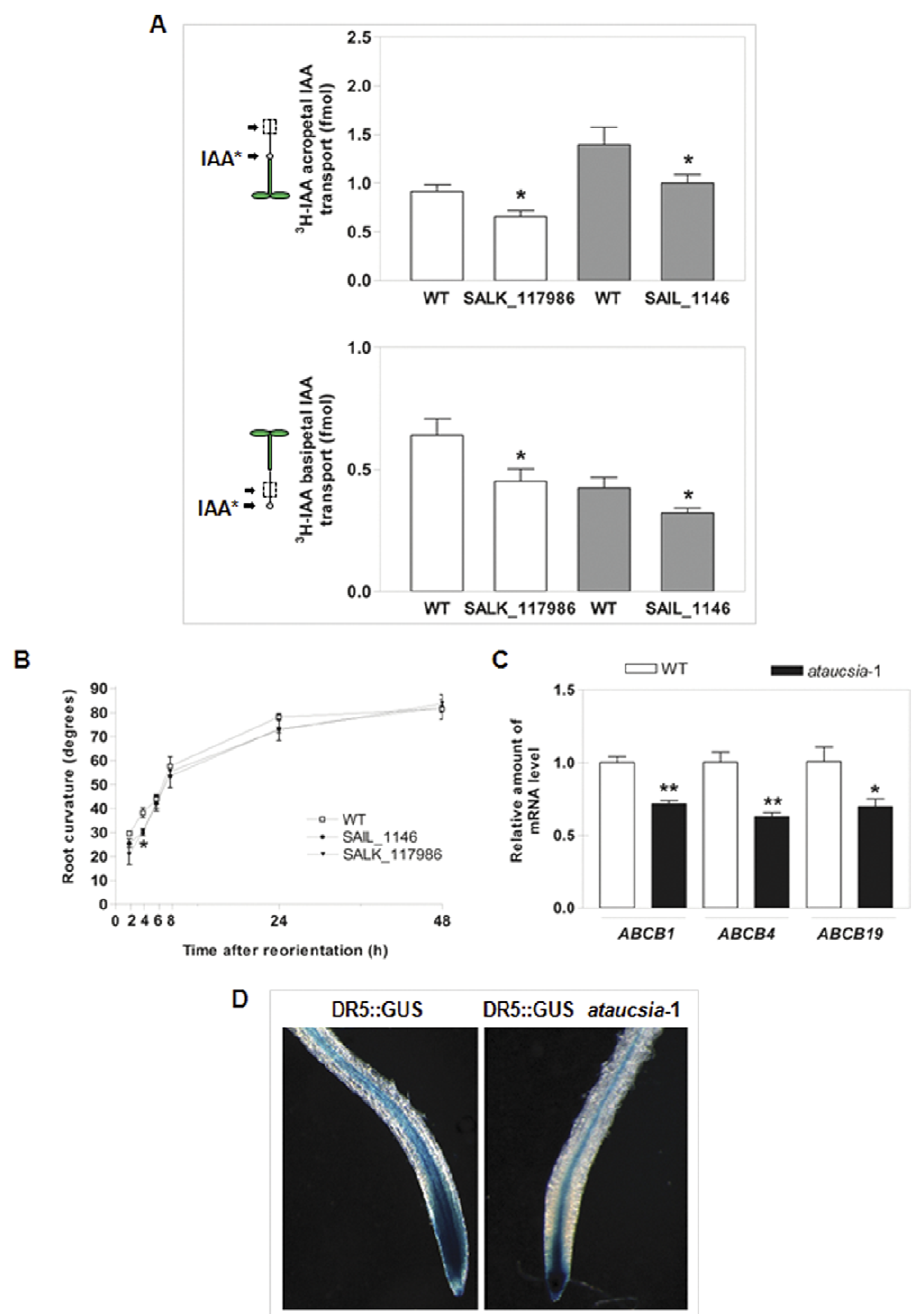
Figure 3. Polar auxin transport in ataucsia -1 mutants. (A) Auxin transport measurement in 5 days old wild-type and ataucsia -1 mutant seedlings. (Upper) For acropetal IAA transport assay, an agar drop containing 3 H-IAA was applied just below the root–shoot junction. (Lower) For basipetal IAA transport assay, 3 H-IAA agar drop was positioned to the apical 0.5 mm of the root tip. The schematic drawings on the left represent the mode of 3 H-IAA application. The boxes indicate the segment in which radioactivity was measured. Results are reported as means 6 SE (n=3) 15–20 seedlings per replicate. (B) Time course analysis of gravitropic curvature in ataucsia -1 mutant and wild-type roots. The root bending was calculated at 2, 4, 6, 8, 24 and 48 h after 90 u reorientation. Results are reported as means 6 SE (n=3) 15–20 seedlings per replicate. (C) Steady state levels of ABCB1 , ABCB4 , and ABCB19 transcripts in wild-type and ataucsia -1 null mutant roots (SALK_117986) evaluated by qRT-PCR. The expression levels were normalized using actin as endogenous control. Relative transcript level for each ABCB gene is the ratio between the expression levels in ataucsia -1 mutant and wild-type roots. The values reported are means 6 SE (n=3). (D) Auxin activity in ataucsia -1 6 DR5::GUS roots. (Left) Wild-type roots expressing DR5::GUS. (Right) ataucsia -1 knock-out line expressing DR5::GUS. Data reported in panel A, B, and C were analyzed by Student’s t -test. *P , 0.05; **P , 0.01; ***P , 0.001 versus wild-type seedlings.